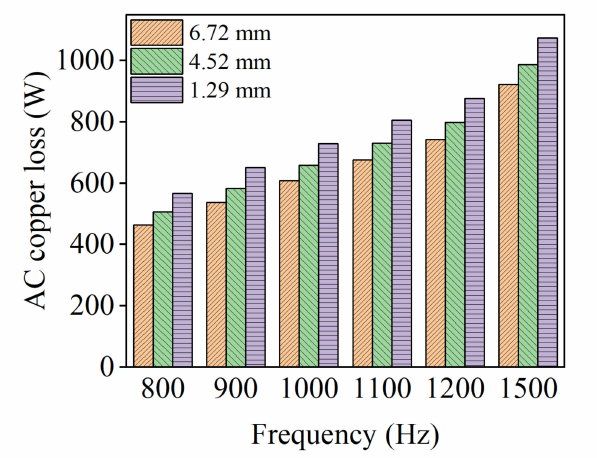
Figure 22. AC copper loss with notch height at different